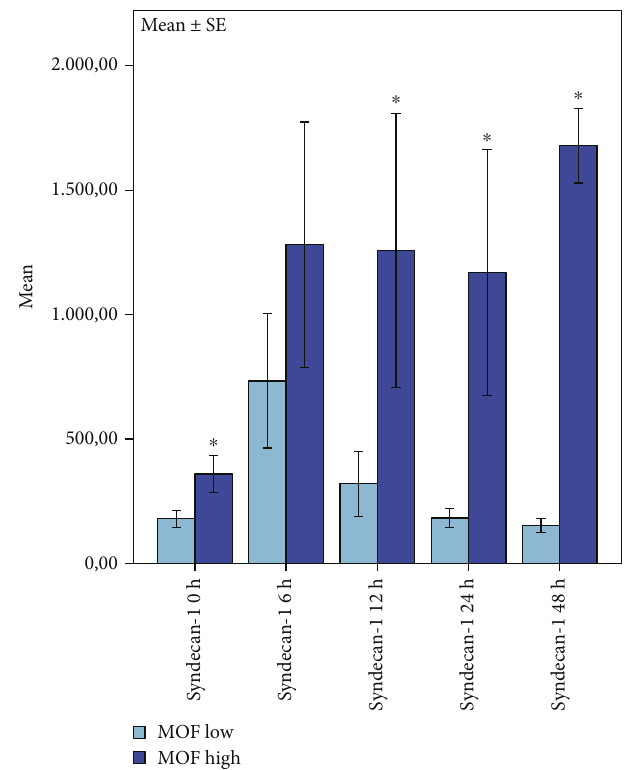
Figure 5: Plots of correlation between syndecan-1 levels and MOF score 48h after cardiac arrest. Highly signi fi cant correlation of syndecan-1, time, and multiple organ failure ( MOF > 6 ); bars represent mean values with error bars representing ± 1 SE. ANOVA analysis of variances and the post hoc Mann-Whitney rank sum test; p ≤ 0 05 ; MOF ≤ 6 : n = 9 , MOF > 6 : n = 4